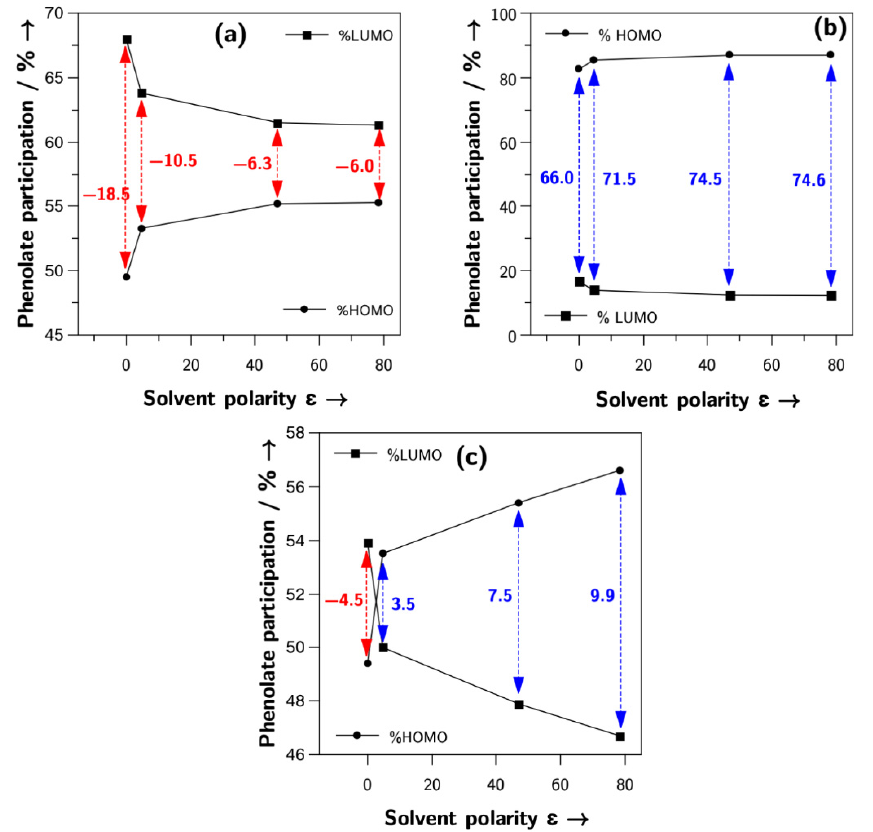
Figure 6. Percentage contribution of the phenolate group in the HOMO and LUMO orbitals for dye 2 ( a ), positive, dye 10 ( b ), negative, and dye 6 ( c ), inverted. CT values are highlighted in red for positive solvatochromism and blue for negative solvatochromism.